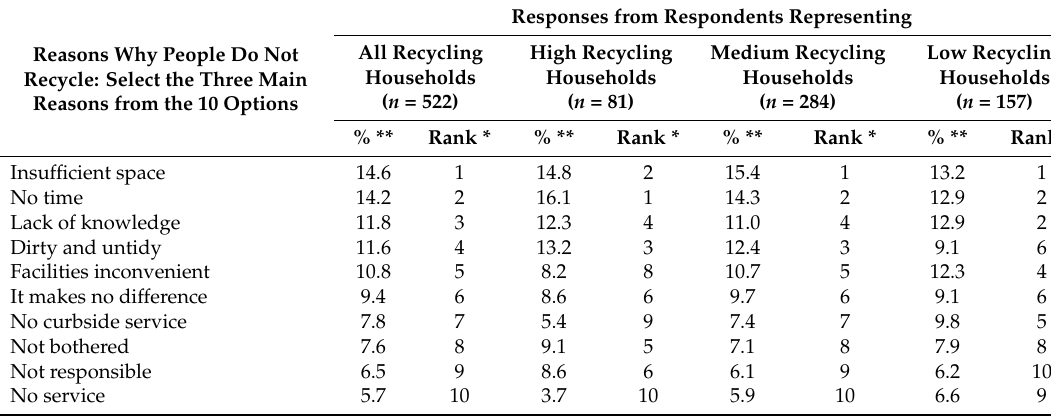
Table 6. Comparing perceptions why people do not recycle across varying recycling levels—order of priority (rank) of the three main reasons why people do not